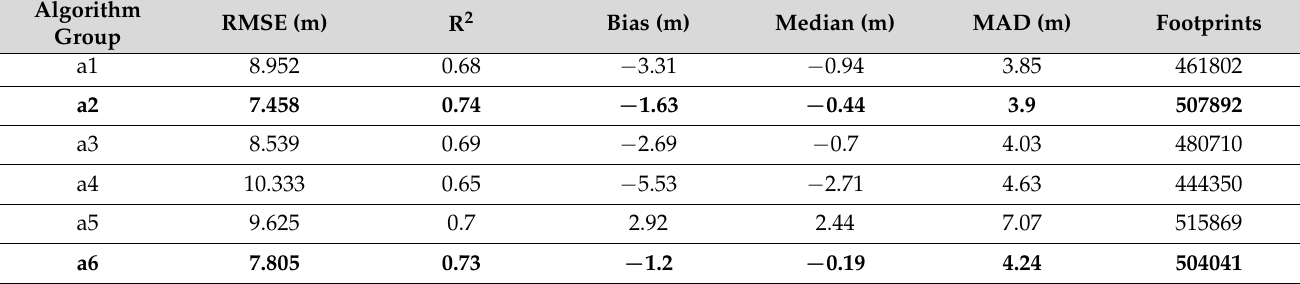
Table 2. Accuracy metrics of GEDI H100 estimates derived with different algorithm